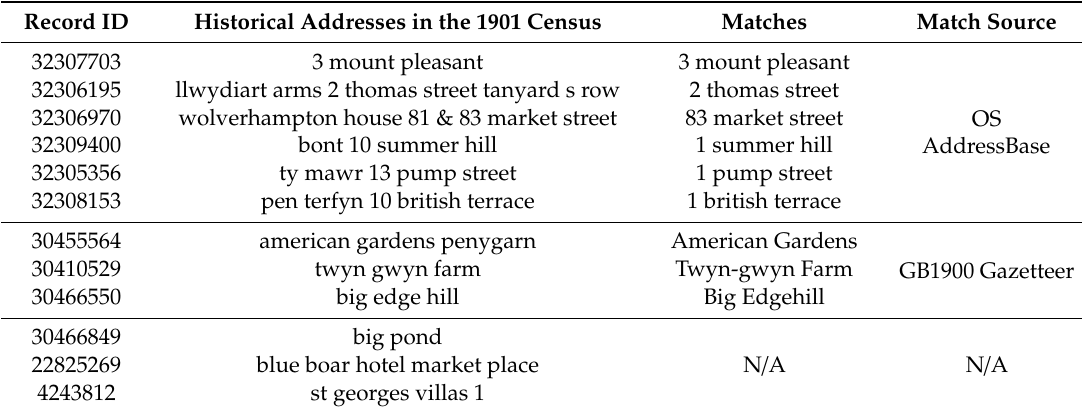
Table 2. Examples of matched and unmatched addresses.